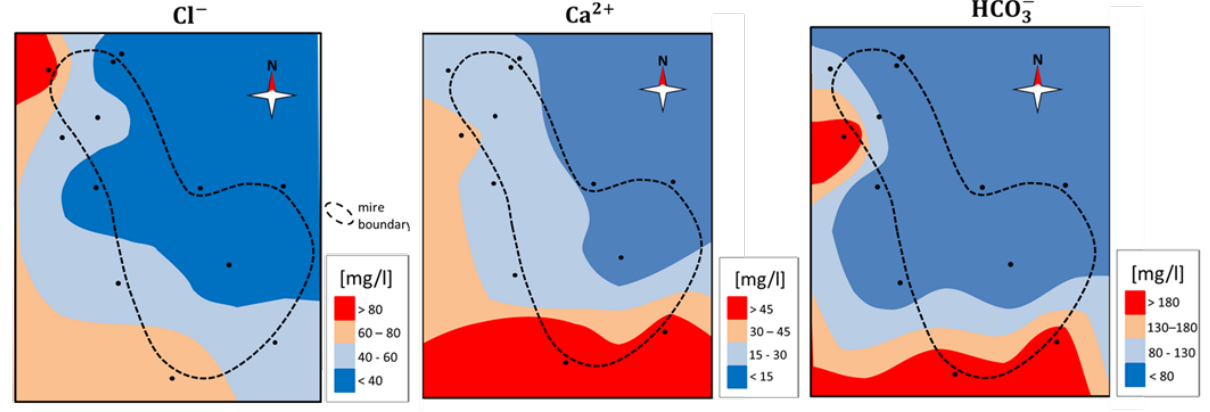
Figure 5. Cl - , Ca 2+ and HCO 3- concentrations of groundwater measured in piezometers in and around